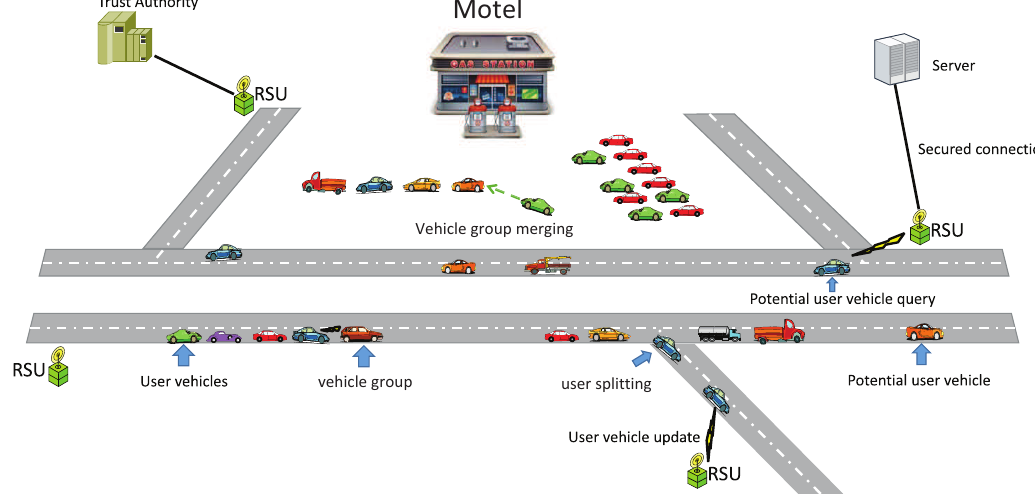
Figure 2. A possible scenario in future vehicular Internet of